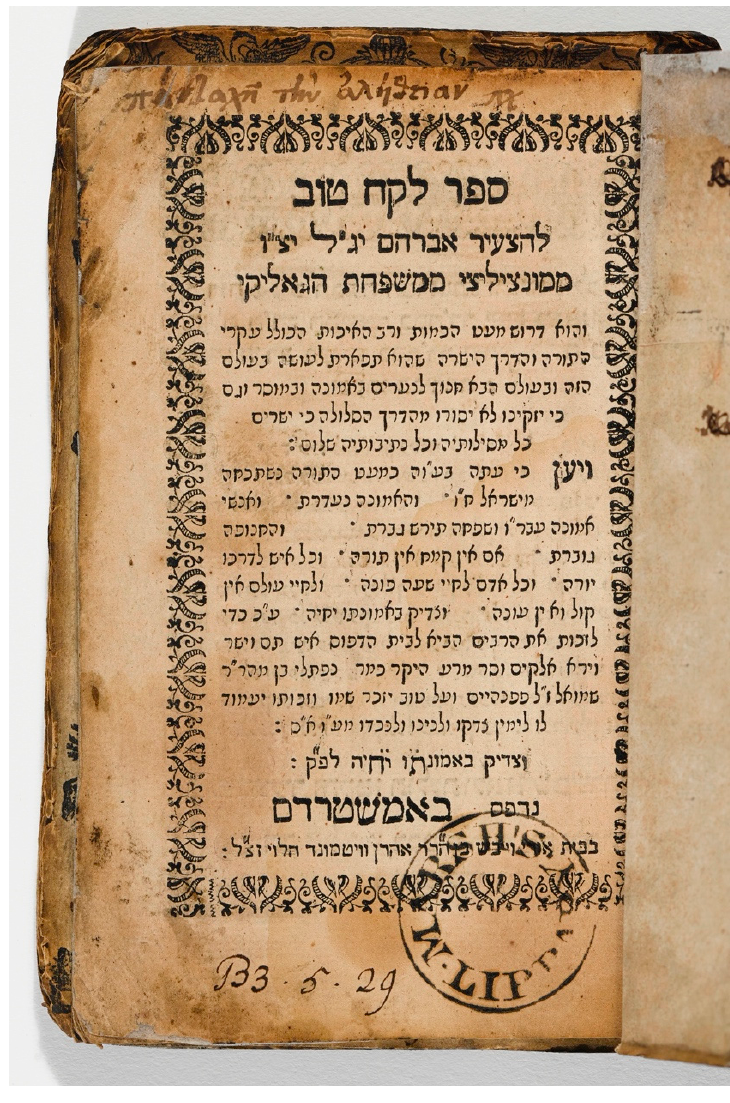
Figure 25. Sefer Lekah Tov; Marsh’s Library B.3.5.29.